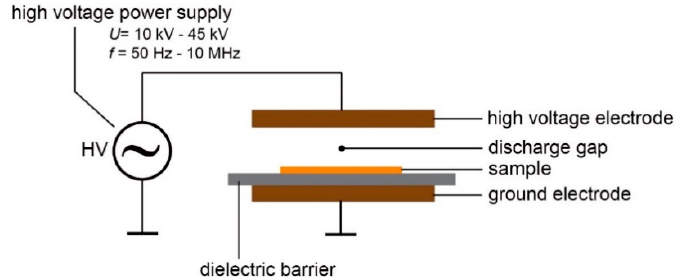
Figure 2. General scheme of the dielectric barrier discharge (DBD) method. The setup consists of two electrodes, the dielectric barrier on or near the one electrode, and the sample between the electrodes. The electrodes are connected to a high voltage power supply, which operates with the voltage between 10 kV and 45 kV and with the frequency between 50 Hz and 10